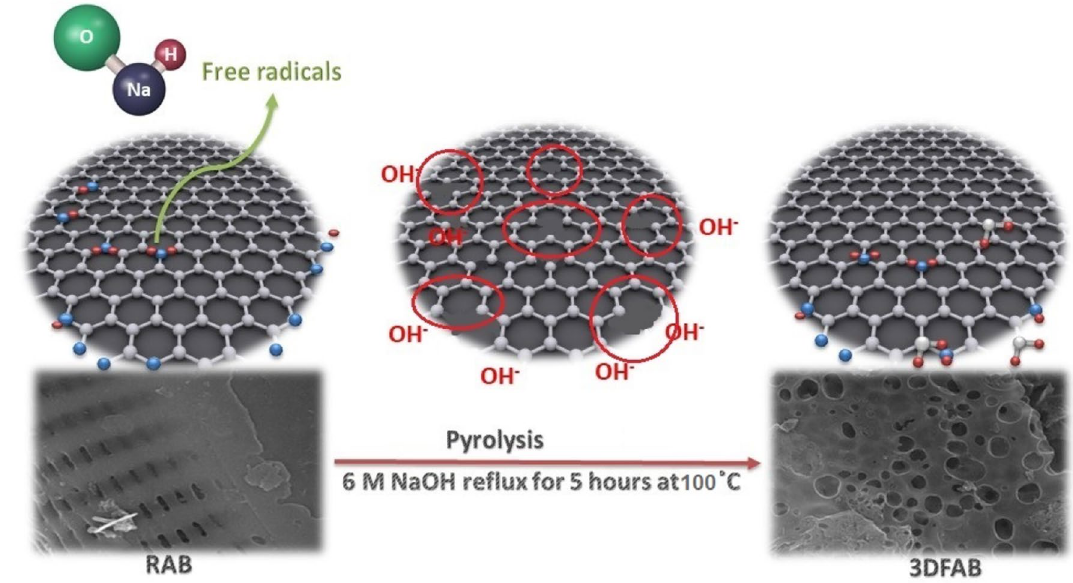
Figure 1. Possible mechanism of NaOH activation for the synthesis of 3FAB.